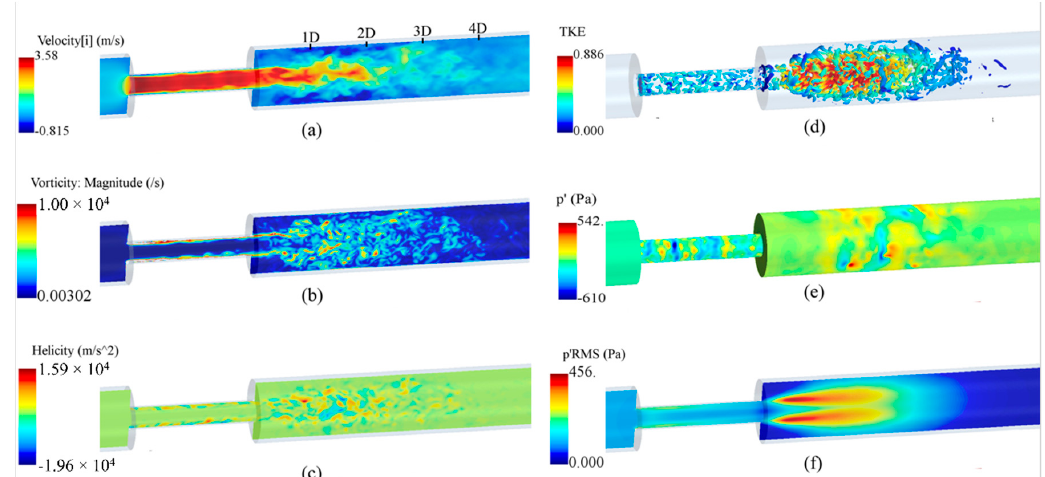
Figure 6. Instantaneous flow parameters: ( a ) axial velocity; ( b ) vorticity; ( c ) helicity; ( d ) the turbulent kinetic energy (TKE) on the isosurfaces of Q-criterion; ( e ) wall pressure fluctuations, and ( f ) root mean square (RMS) of the pressure fluctuations at the middle cross-section of the flow domain.